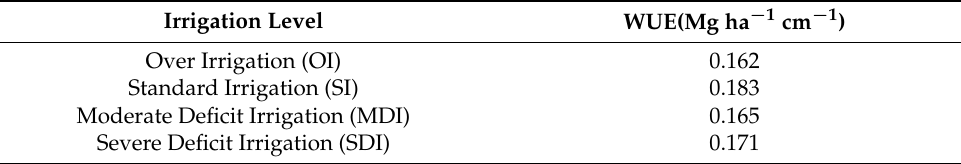
Figure 5. The WUE of alfalfa under deficit irrigation using subsurface drip irrigation. The blue dots show individual WUE per alfalfa harvest. Table 6. Water use efficiency (WUE) of alfalfa from 2018–2022.